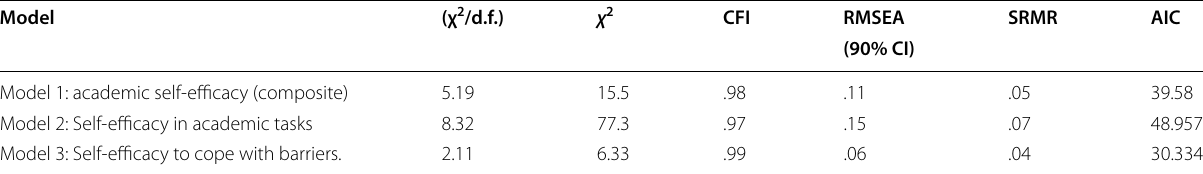
Table 4 Summary of fit indices for models’ comparisons ( n